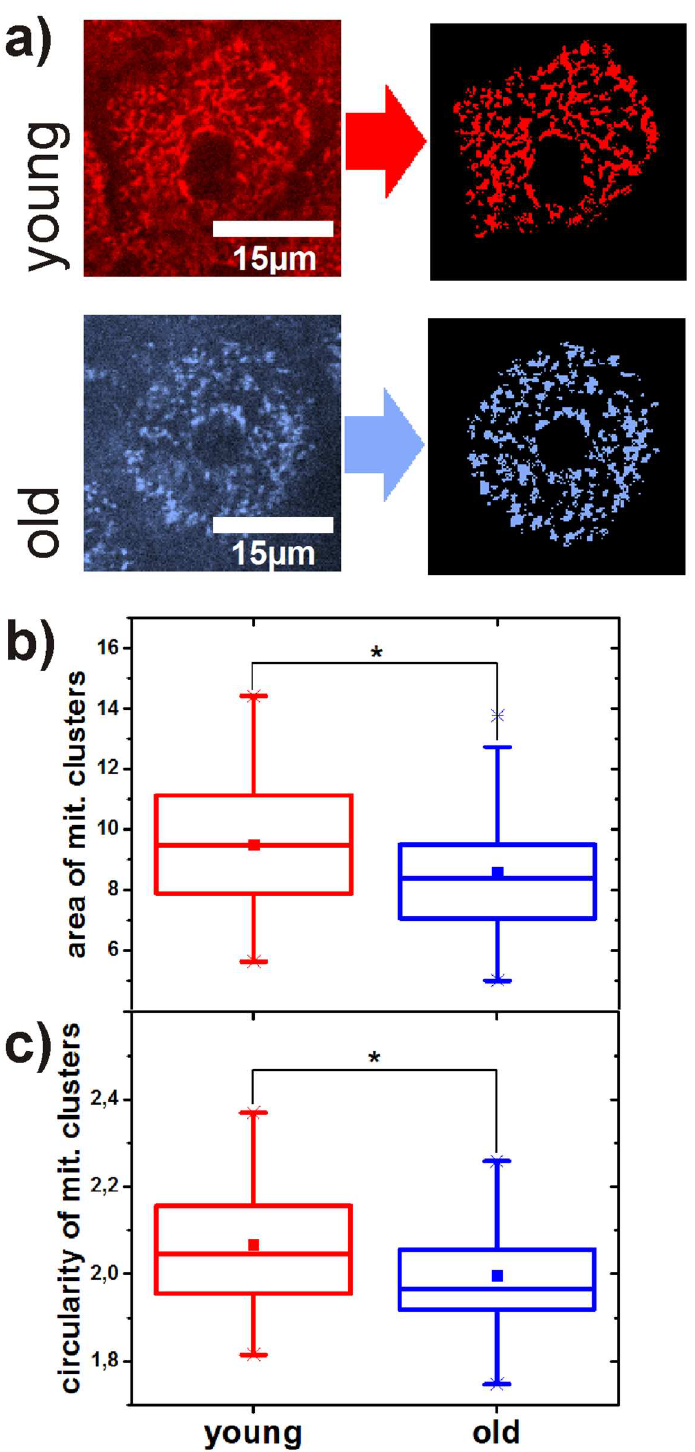
Fig 2. (a) Comparisonof mitochondrial networksin youngvolunteersand old volunteersbefore and after binarization. Age-related comparisonof size (b) and circularity (c) of mitochondrial clusters in keratinocytes. The p-value represents the probabilityif the two comparedprobabilitydistributions derive from the same population. The square in the box representsthe mean value, the horizontal line in the center the median. 25% percent of the measuredvalues are lower than the bottom of the box, 75% of them are lower than the top of the box. The antennas (whiskers) are the corresponding limits for 2.5% and 97.5%. Crosses represent the highestand the lowest value in the